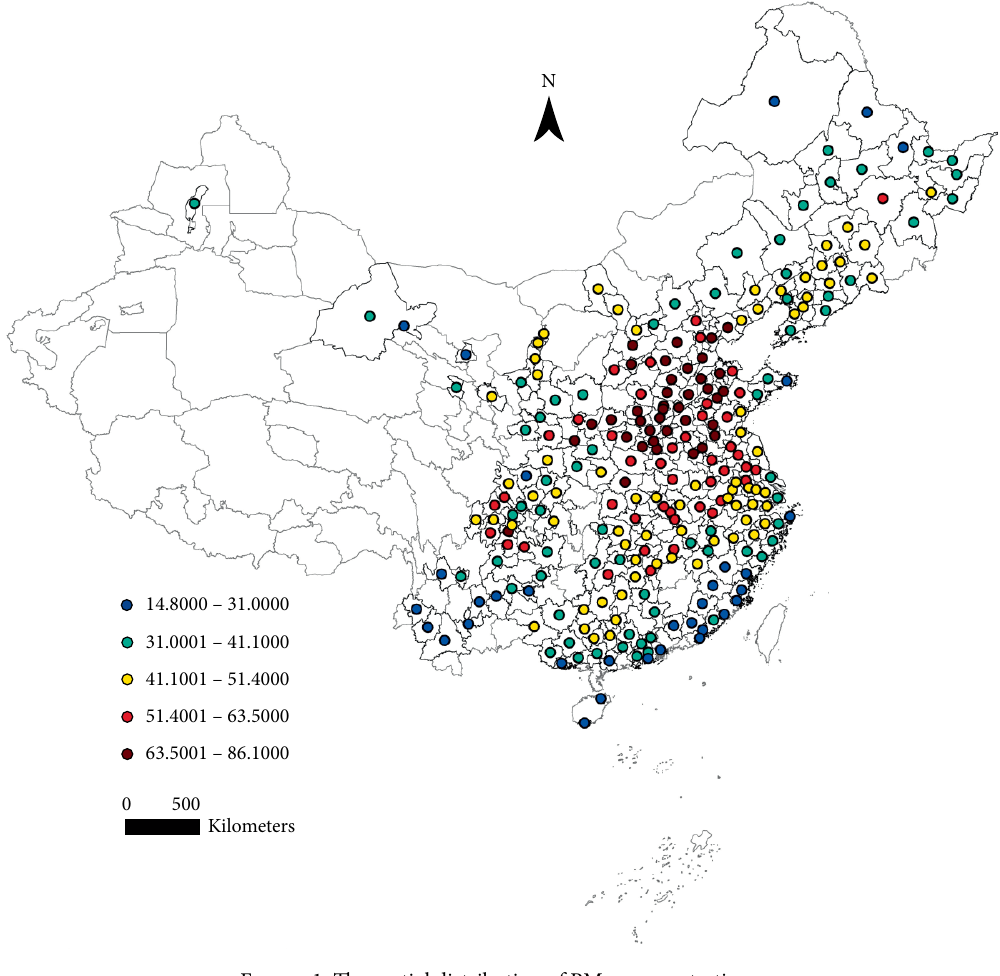
Figure 1: The spatial distribution of PM